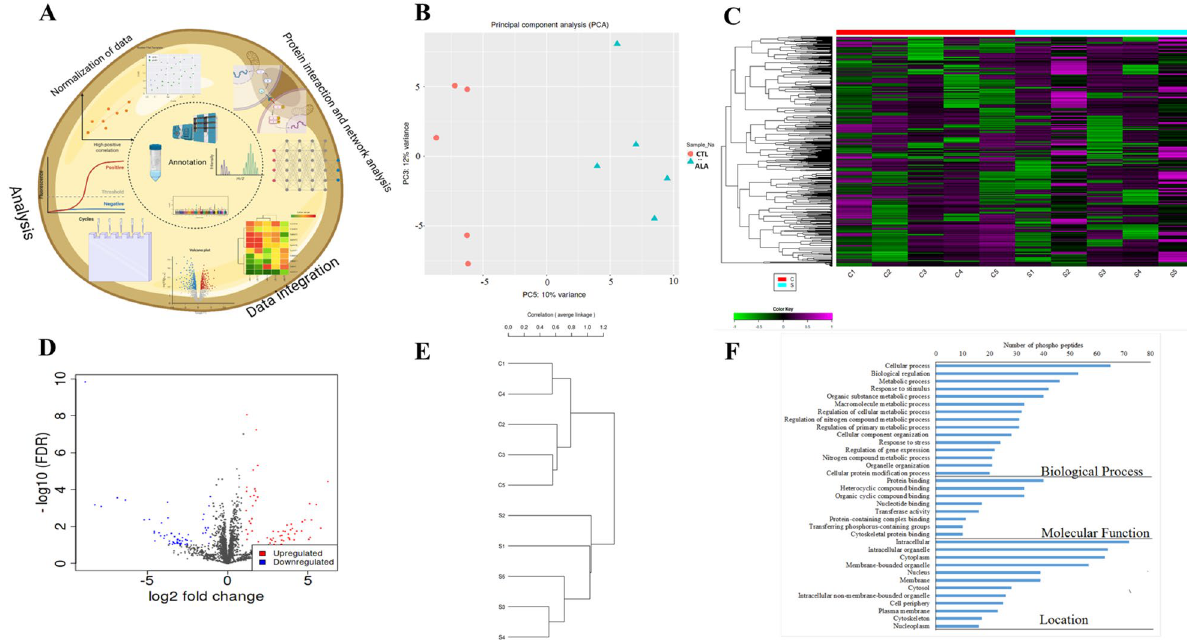
Figure 3. Phospho-proteomic analysis of insulin-stimulated adipose tissue from postpartum (PP) of dairy cows supplemented peripartum with ALA. Dairy cows were divided into two groups from 21 to 60 days PP; (i) CTL—encapsulated saturated fat, (ii) ALA—flaxseed supplement providing α-linolenic acid (ALA). n = 5 per treatment. ( A ) Work flow diagram of phospho-proteome analysis. ( B ) Principal component analysis (PCA) of AT phospho-proteome; CTL samples are denoted as red circles, whereas ALA samples are denoted as blue triangles. ( C ) Heat map analysis of AT phospho-proteome, low phosphopeptide intensity is denoted in green, whereas high intensity is denoted in purple. Each cow in the study is numbered and represented in columns. ( D ) Volcano plot analysis of AT phospho-proteome; the P value (≤ 0.05) is represented on the Y-axis and FDR (± 1.5) is represented on the X-axis. Each dot represents one protein; red indicates more, whereas blue indicates fewer phosphoproteins in AT. ( E ) Correlation of CTL vs ALA adipose generated by the IDEP9.5 server where c1, c2, c3, c4, and c5 represent CTL; s1, s2, s3, s4, and s5 represent ALA-supplemented cows. ( F ) GO analysis of AT phosphoproteome supplemented with ALA including the biological process category, the molecular function category, and the cell component category. Image was generated using www. Biore nder.